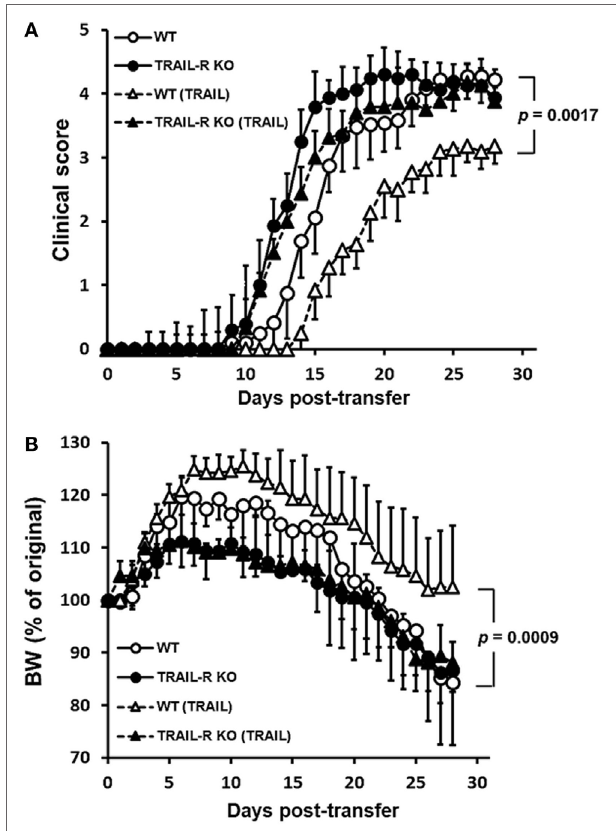
FigUre 4 | TRAIL-treated myelin oligodendrocyte glycoprotein (MOG)- activated T cells reduced disease activity in adoptive transfer-induced experimental autoimmune encephalomyelitis (EAE). Th17-polarized MOG 35–55 -activated T cells were generated from wild-type (WT) and TRAIL-R KO mice after EAE immunization, as described in Section “Materials and Methods.” MOG 35–55 -activated splenic Th17 cells were stimulated with anti-CD3 (1 µg/ml) and anti-CD28 (1 µg/ml) antibodies in the presence or absence of TRAIL (10 µg/ml) for 24 h and adoptively transferred into Rag1 KO mice (5 × 10 6 CD4 + T cells/recipient). Adoptive transfer recipients were monitored daily for clinical paralysis and body weight changes. The daily (a) mean clinical score ± SD and (B) percentage of body weight change ± SD are presented for each group. Statistics were calculated by the two way ANOVA. Data shown are from one experiment with 12 mice/group representative of three